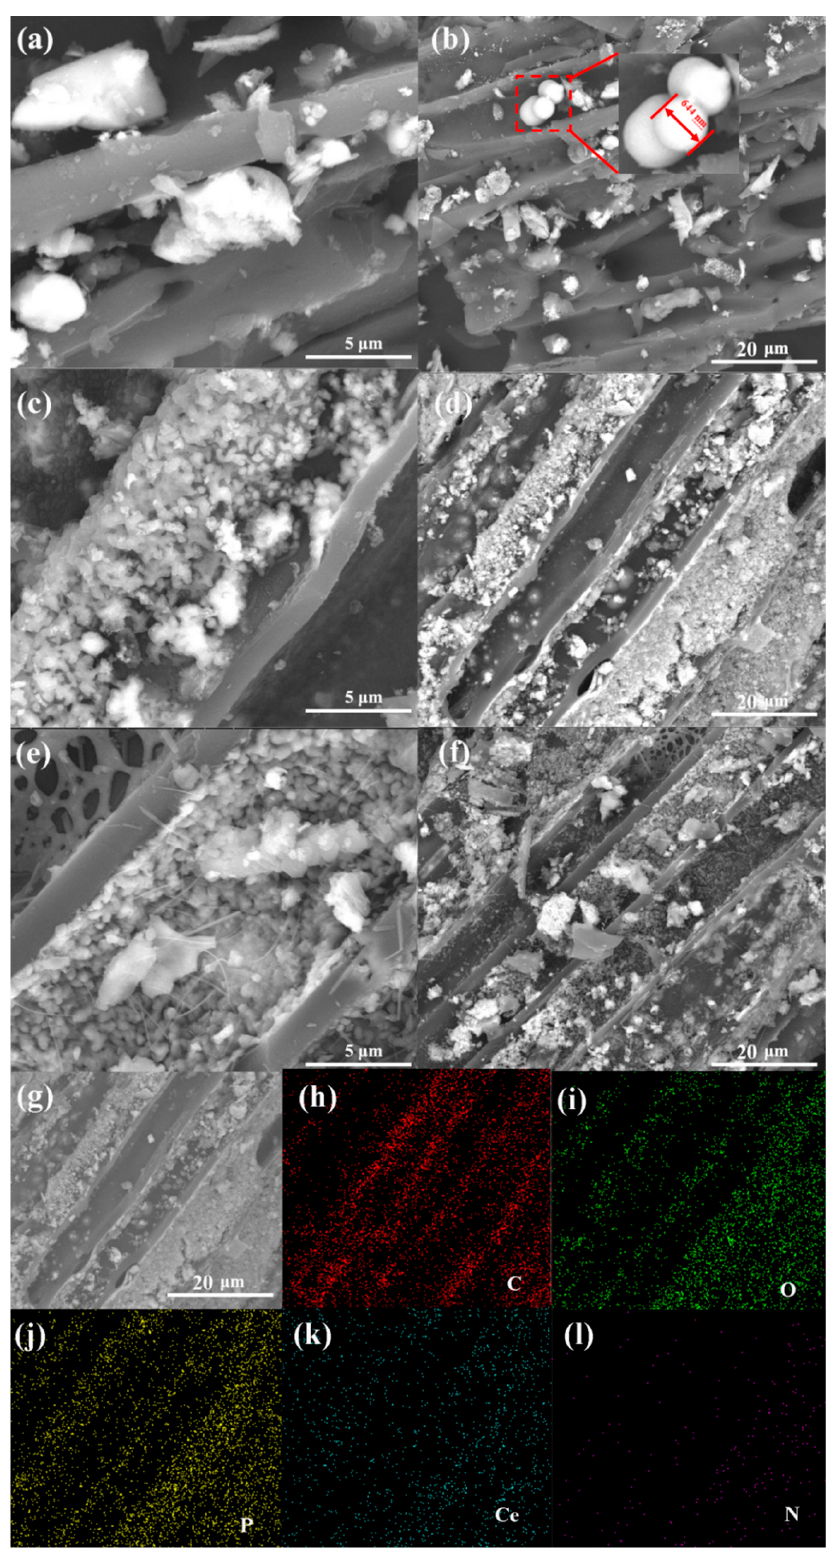
Figure 3. SEM ( a , b ): 450 Ce-SPC ( c , d ): 600 Ce-SPC ( e , f ): 500 Ce-SPC, EDS elemental mapping image of 600 Ce-SPC ( g − l ).